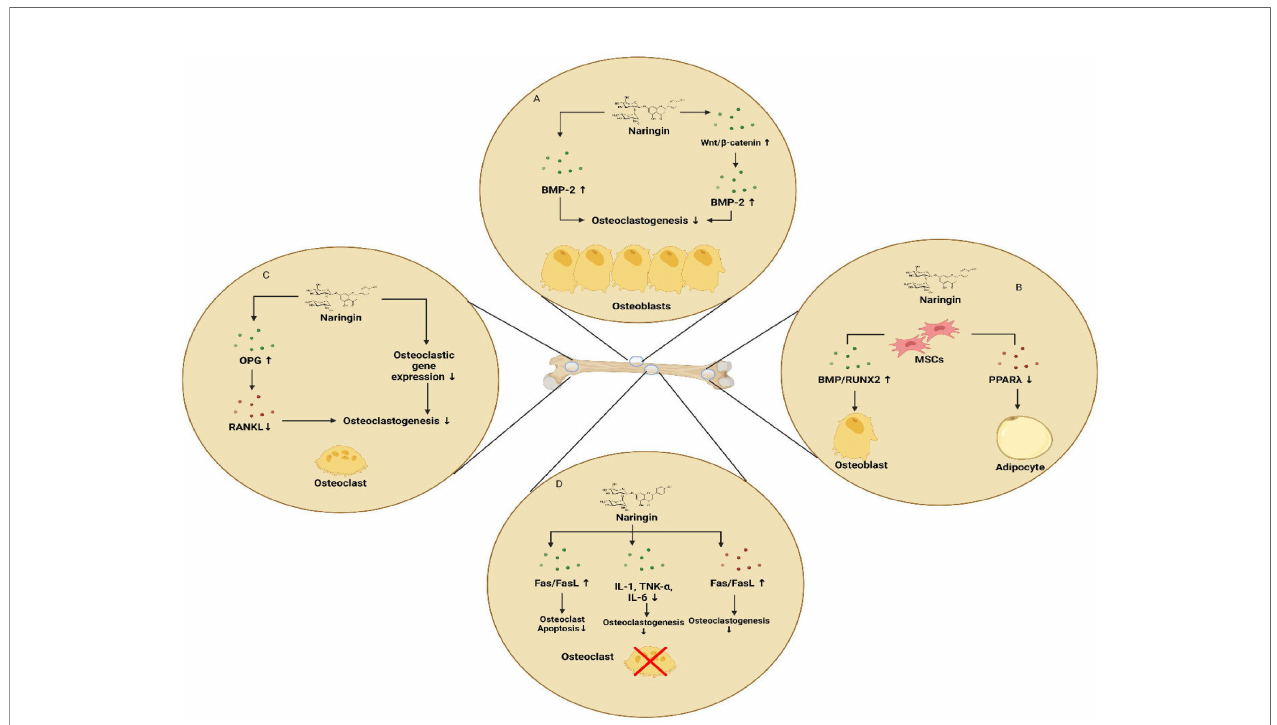
FIGURE 5 | Effects of naringin on bone (A) naringin-induced upregulation of osteoblastogenesis via regulation of BMP-2 and Wnt/ b -catenin pathways (B) upregulation of osteoblastogenesis and downregulation of adipogenesis (C) inhibition of osteoclastogenesis and osteolysis by naringin mediated by the inhibition of RANK/RANKL interaction (D) inhibition of bone resorption by inducing apoptosis of osteoclasts and reducing in fl ammatory cytokines that induce osteoclast